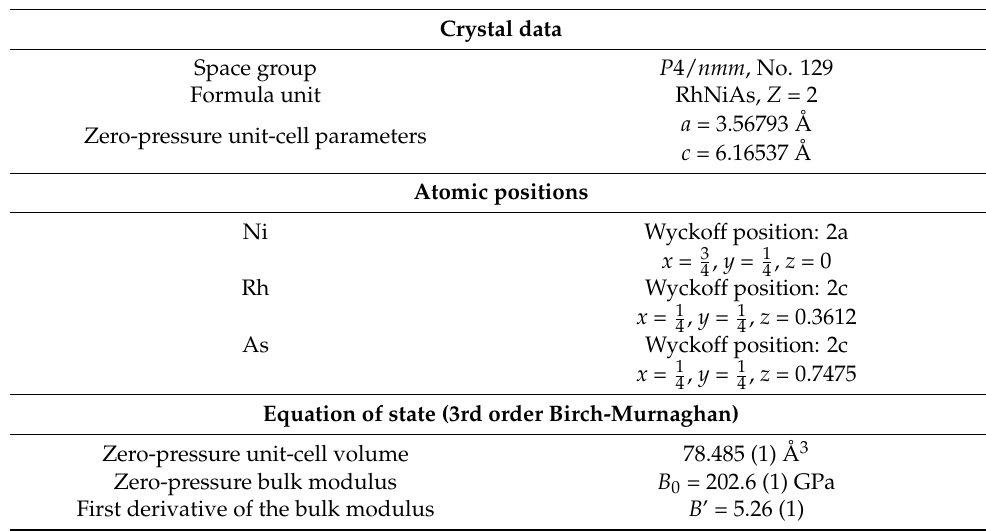
Table 2. Calculated structural data for zaccariniite (RhNiAs) obtained from DFT calculations within the generalized gradient approximation (GGA), with Perdew–Burke–Ernzerhof (PBE) parametriza- tion, including vdW corrections (Grimme’s D2